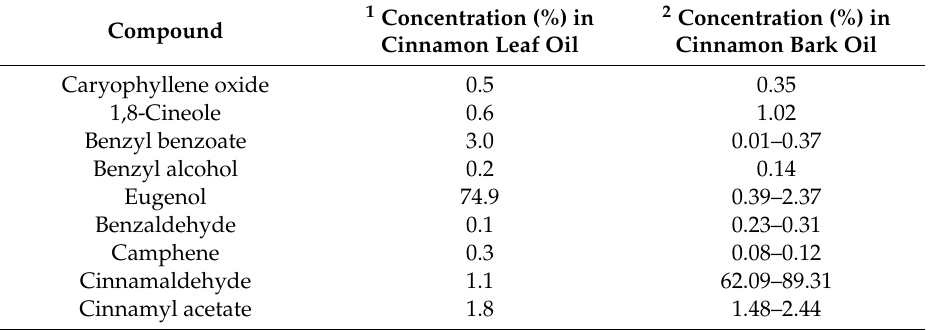
Table 1. The concentration of some of the constituents identified in the cinnamon oil (leaf and bark).